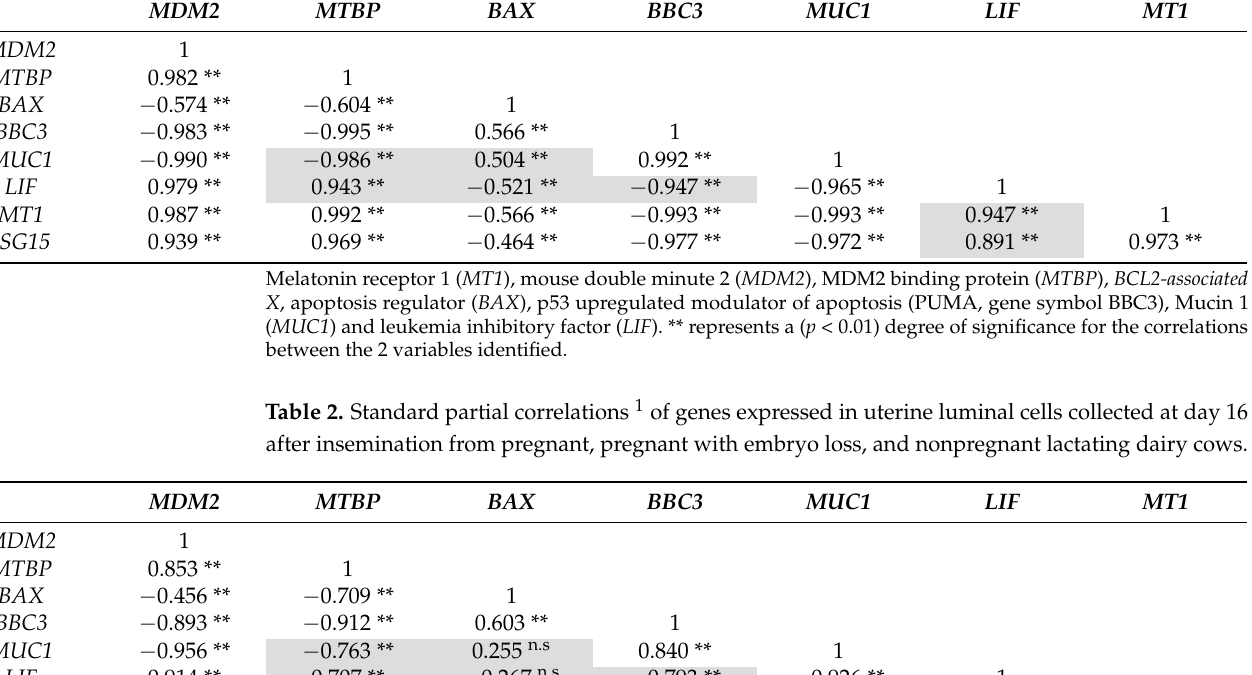
Figure 4. The potential integrated associations of gene expression supporting the schematic are depicted in Figure 4. Increased plasma concentrations of melatonin at insemination and early pregnancy acting via increased MT1 receptor expression enhances MDM2 gene expression at day 16 (Figure 3). Gene expressions of LIF and MDM2 appear to be central intracellular focal points leading to an ultimate decrease in gene expression of mucin. This appears to be mediated by a MDM2 -induced increase in MTBP expression acting in concert with ISG15 expression leading to a decrease in Mucin expression. Concurrently, increased MT1 expression acting in concert with ISG15 expression enhances expression of LIF that targeted a moderate decrease in BAX gene expression. The decrease in BAX expression would reduce the positive effect of BAX on Mucin expression. An additional critical factor intracellularly is the degree of mitochondrial regulation of apoptosis. High expression of LIF in pregnancy at day 16 is associated with low gene expression of BBC3 in the two nonpregnant statuses (Figure 3). Expression of BBC3 is a major upstream regulator of the apoptotic pathway in mitochondria that ultimately influences both nuclear and mitochon- drial pathways leading to cellular apoptosis. The high LIF expression associated with a negative decrease in BBC3 expression (Figures 3 and 4) exerts an antiapoptotic effect, partly associated with ISG15 expression in blood